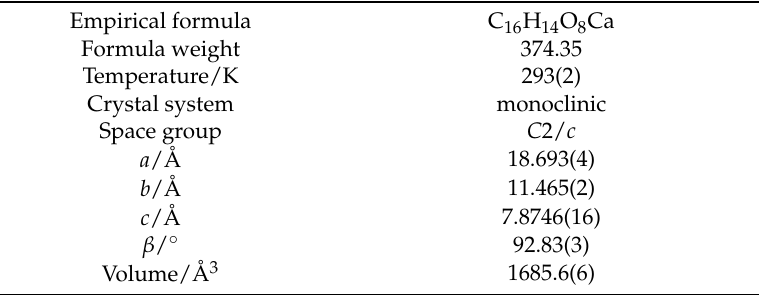
Table 1. Data collection and handling for [Ca(L) 2 (H 2 O) 2 ] n